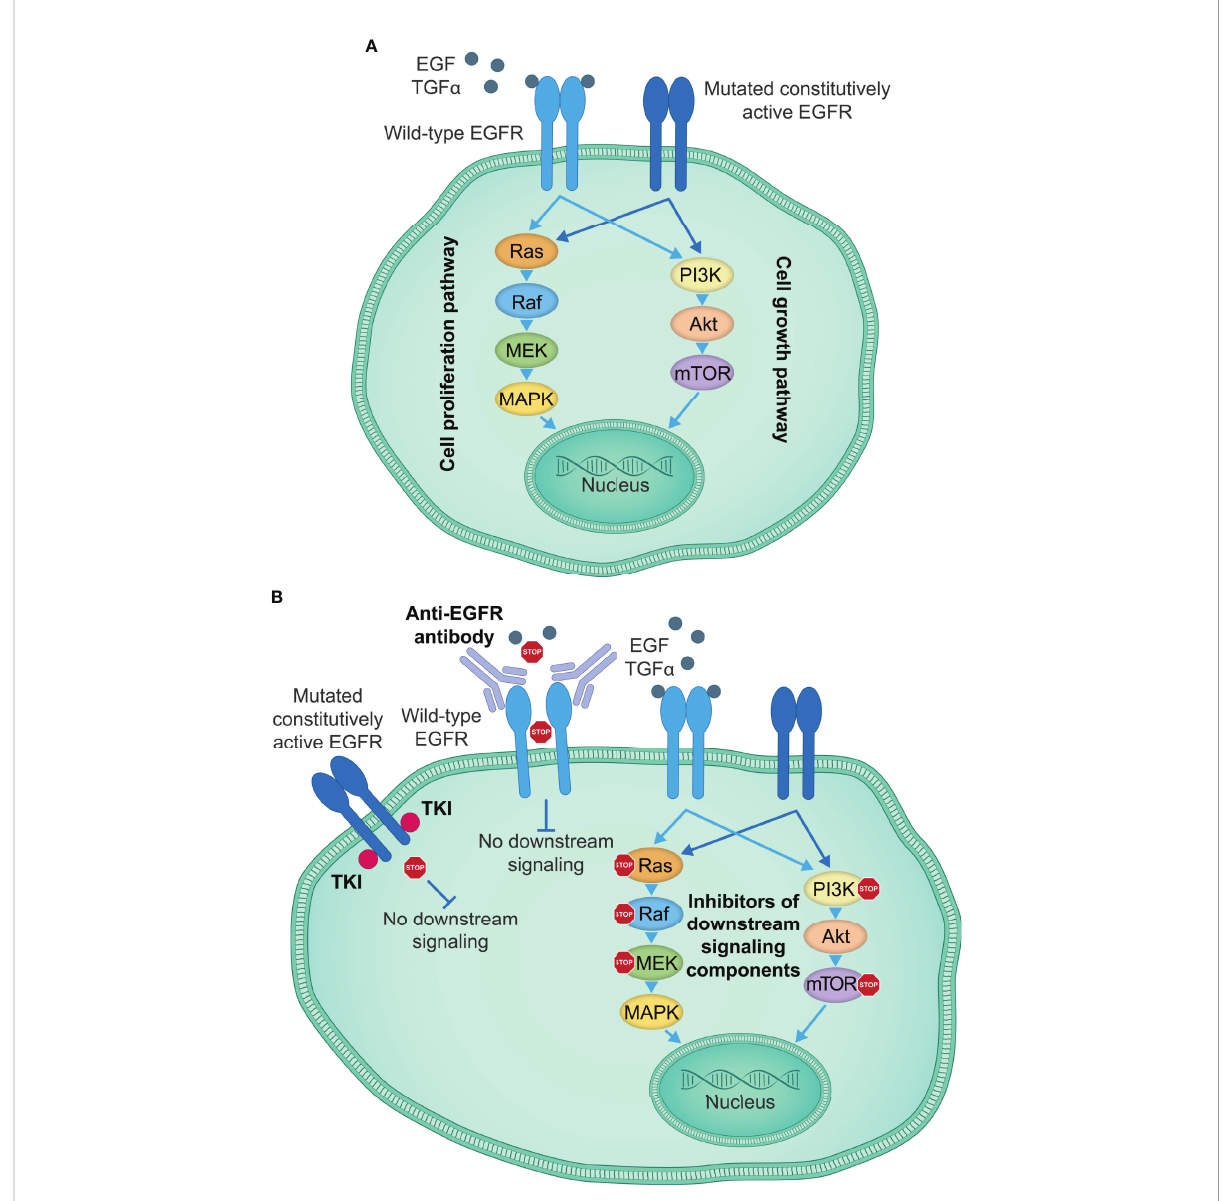
FIGURE 1 EGFR-targeting therapies inhibiting EGFR activation and signal transduction. (A) EGFR signaling induced by speci fi c ligands, including EGF and TGF a among others, starts with the conformational switch upon binding of a ligand to the EGFR extracellular domain, the dimerization of EGFR monomers and transphosphorylation of intracellular tyrosine kinase domains, which creates docking sites for the adaptor molecules, leading to the activation of key downstream signaling pathways that govern cell proliferation and growth. Certain mutations in the EGFR kinase or extracellular domain induce a constitutively active state and ligand-independent oncogenic signaling downstream of activated EGFR, thus causing uncontrolled tumor cell proliferation and growth. (B) Currently approved therapeutic agents for the treatment of patients with lung or colorectal cancer, or SCCHN include TKIs targeting the EGFR kinase activity (e.g., fi rst-generation small-molecule EGFR kinase inhibitors ge fi tinib, erlotinib and icotinib), which show particularly high ef fi cacy in the presence of activating EGFR kinase domain mutations, and anti- EGFR antibodies (e.g., cetuximab) that prevent binding of a ligand to the wild-type EGFR and the activation of EGFR and the downstream signaling cascades. Other therapeutic approaches take advantage of individual signaling components downstream of EGFR to disrupt the EGFR signaling cascades and impair tumor cell proliferation and growth. EGF, epidermal growth factor; EGFR, EGF receptor; SCCHN, squamous cell carcinoma of the head and neck; TGF a , transforming growth factor a ; TKIs, tyrosine kinase